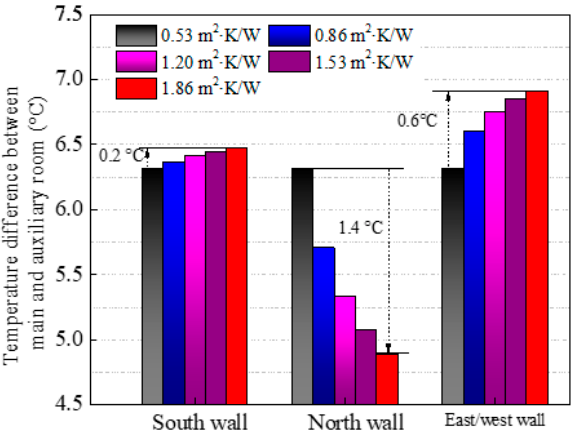
Figure 13. Temperature differences between main and auxiliary rooms caused by increasing the thermal resistance of exterior walls.